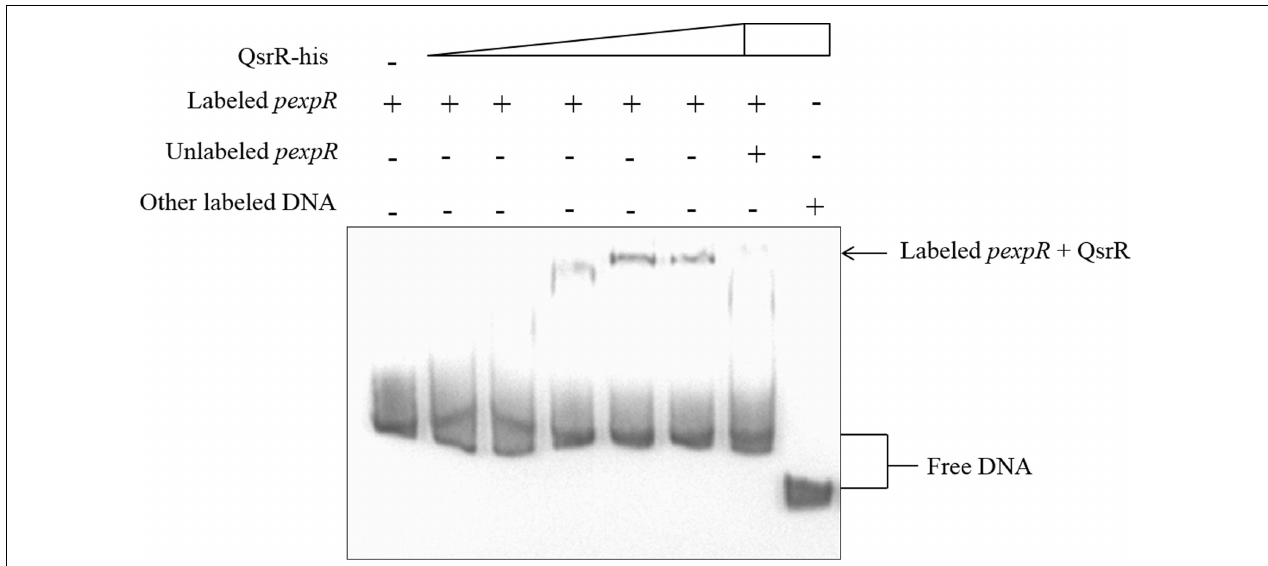
FIGURE 5 | Electrophoretic mobility shift assays confirmed direct binding of QsrR to the expR promoter ( pexpR ). pexpR is a 286 bp DNA fragment from the translational start codon of gene expR . Each lane contained 0.005 nM of labeled pexpR . The labeled pexpR and a ∼ 100-fold excess of the unlabeled pexpR were used in competitive assays. Labeled non-specific DNA from Streptomyces avermitilis was used as negative control. The amount of His 6 -QsrR added in each lane were 0 µ M, 0.92 Mm, 1.65 µ M, 2.38 µ M, 3.3 µ M, 4.77 µ M, 4.77 µ M, and 4.77 µ M,